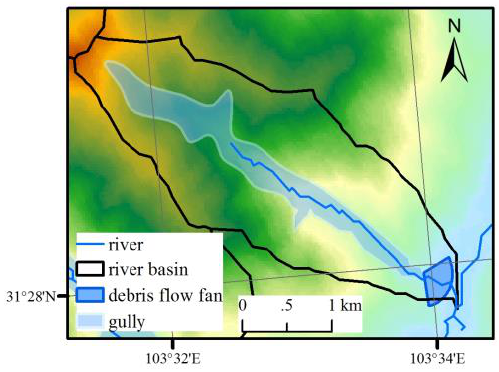
Figure 2. The potential path in the gully and the resultant alluvial